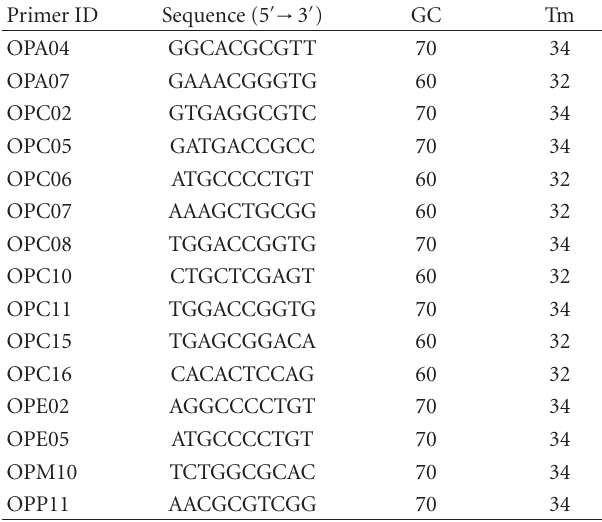
Table 1: Sequence, GC content, and melting temperature of prim-